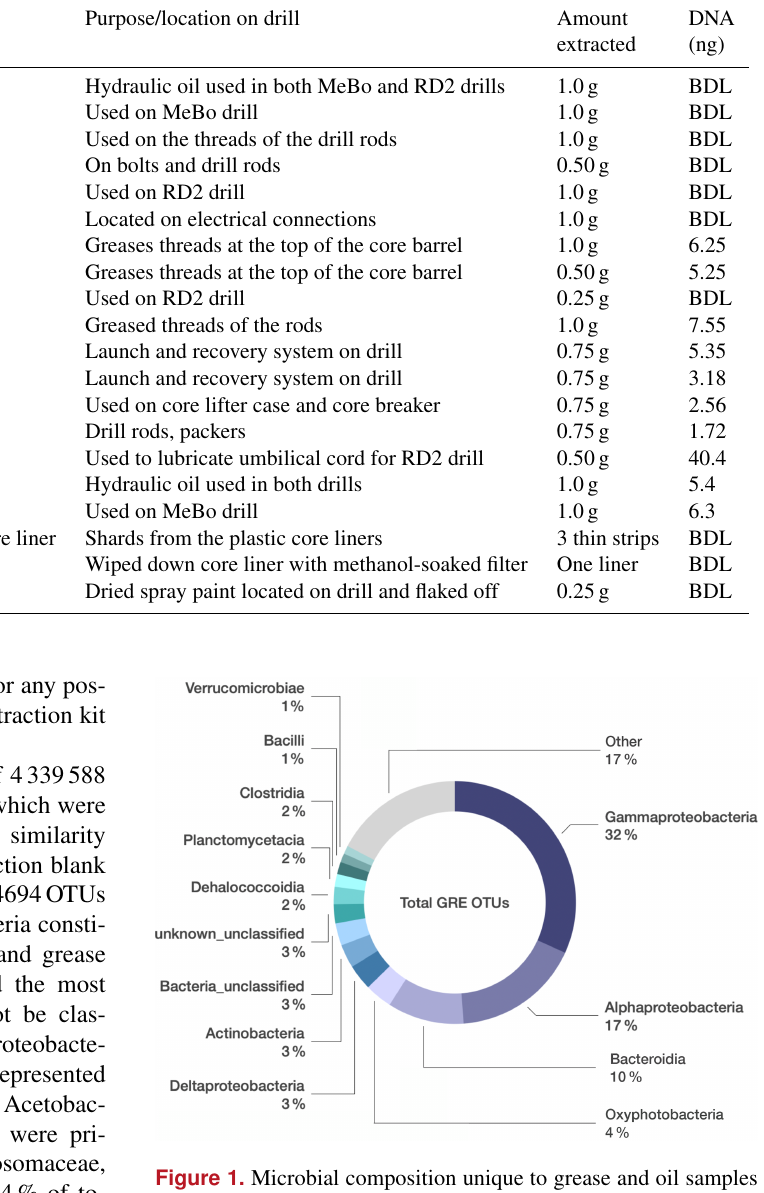
Figure 1. Microbial composition unique to grease and oil samples used on seafloor drills. Relative abundance of bacterial classes iden- tified in grease and oil samples. Sequences that were also present in the controls (extraction kit blank, lab air, and MilliQ water) were manually removed from the dataset. “Other” includes 95 additional classes whose relative abundance was < 1% of the total community